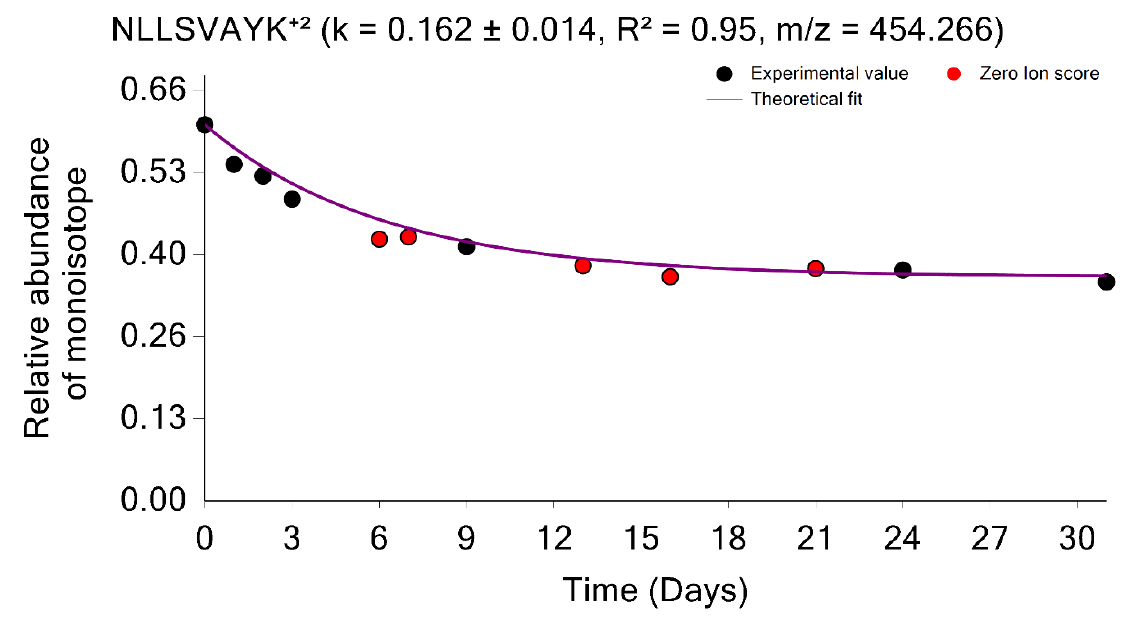
Figure 6. Time course plot of monoisotopic RIAs for NLLSVAYK +2 peptide from the 1433B_MOUSE protein. The experimental time points quantified using the match between runs are shown in red.